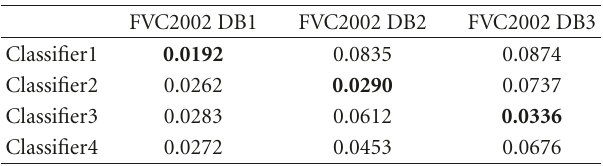
Table 6: Average error rates of Chen’s method for cross-database